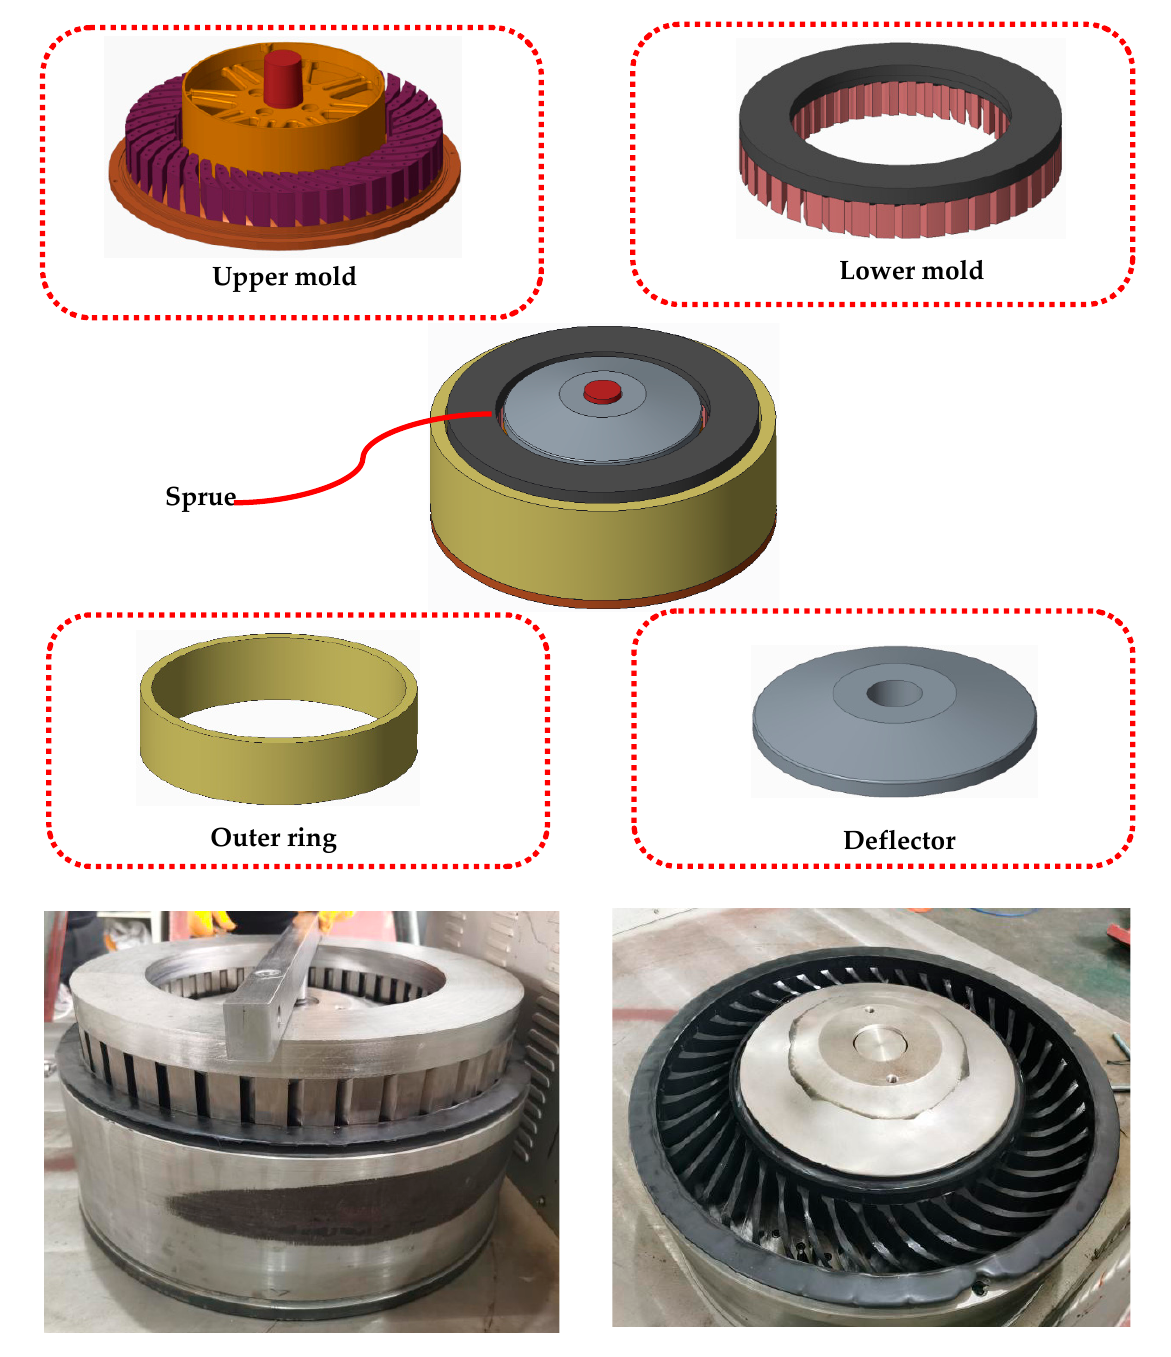
Figure 8. Forming of spoke.